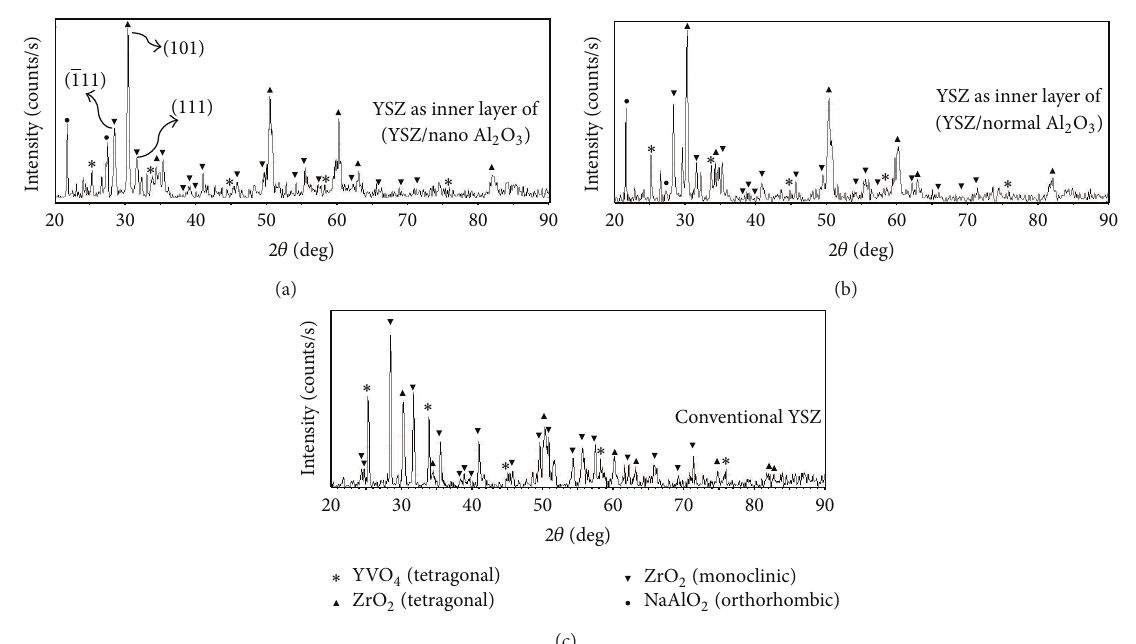
corrosion test; therefore Figure 11(e) indicates the surface of YSZ as inner layer of YSZ/nano-Al 2 O 3 coating after hot corrosion